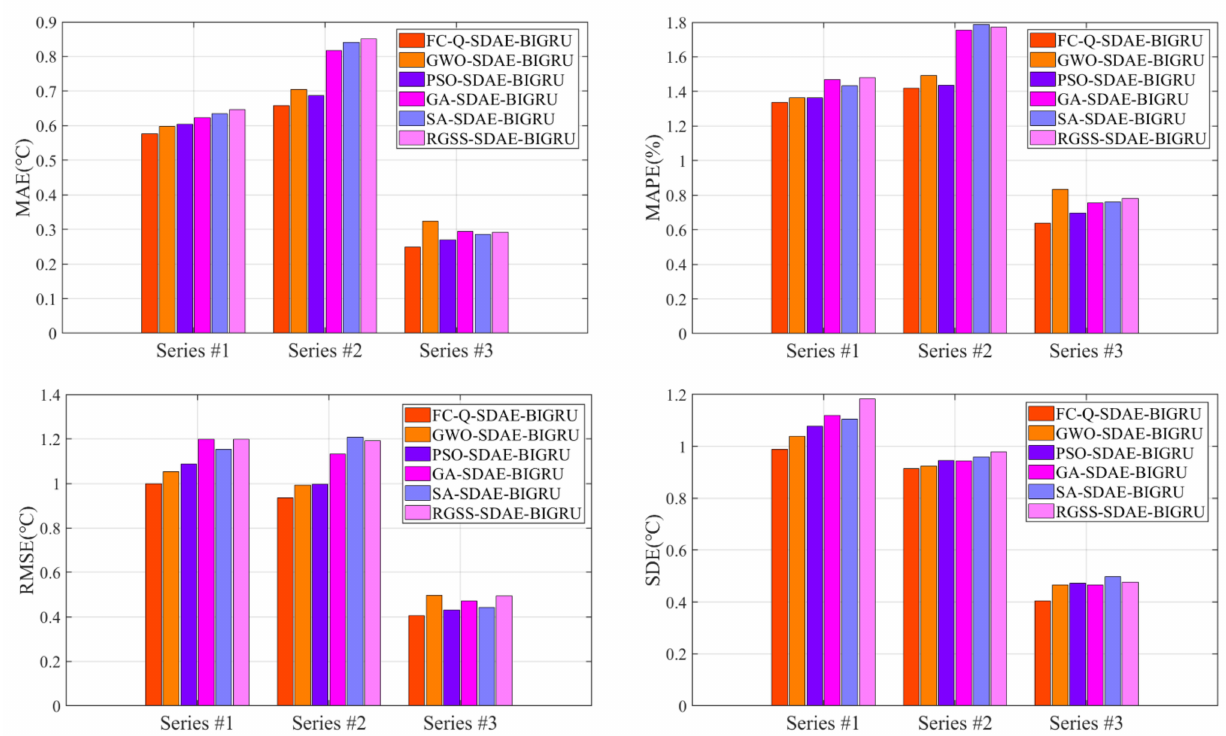
Figure 10. Forecasting performance evaluation indexes: MAE, MAPE, RMSE, and SDE values of different feature selection methods.